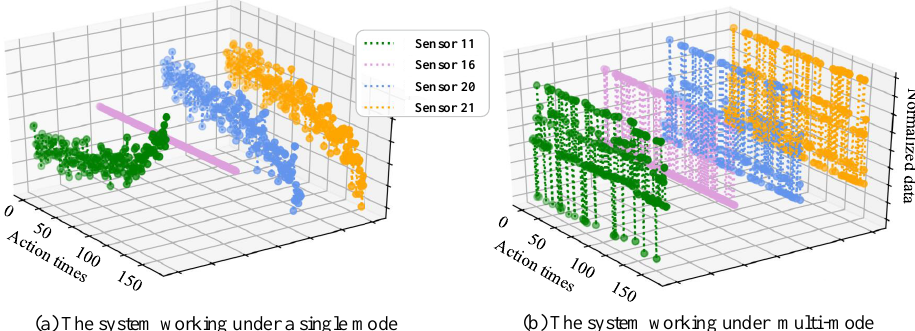
Figure 5. The trends of four sensors in different working conditions. ( a ) System working under a single mode in FD001. ( b ) System working under multi-modes in